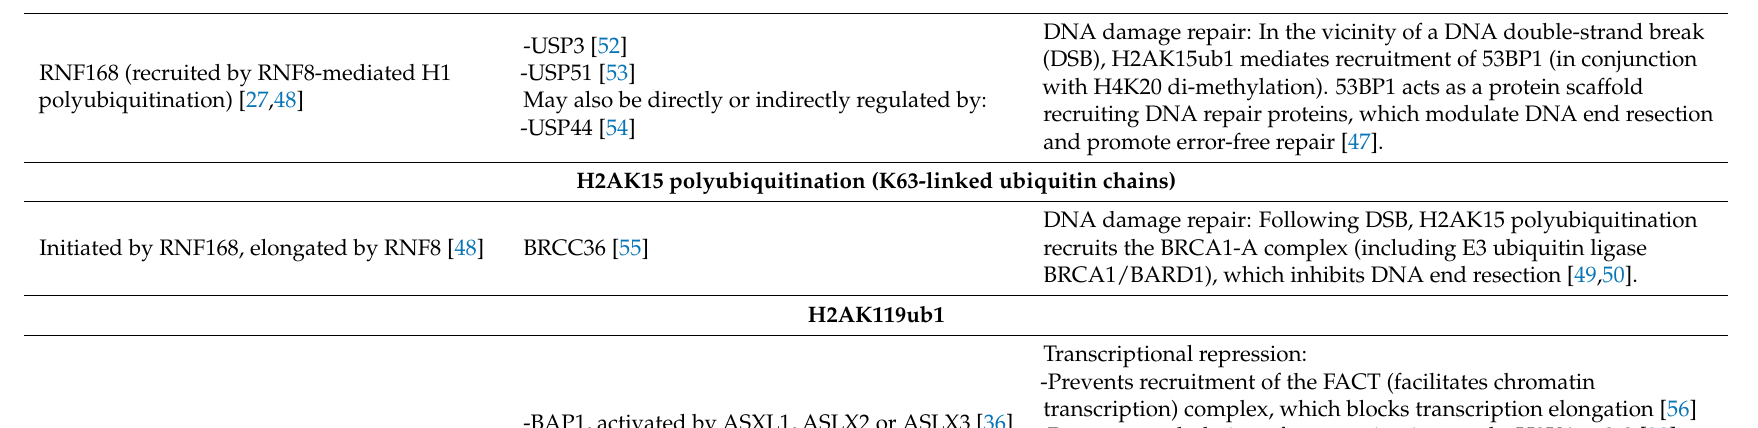
Table 1. Functions and regulation of histone H2A ubiquitination marks.